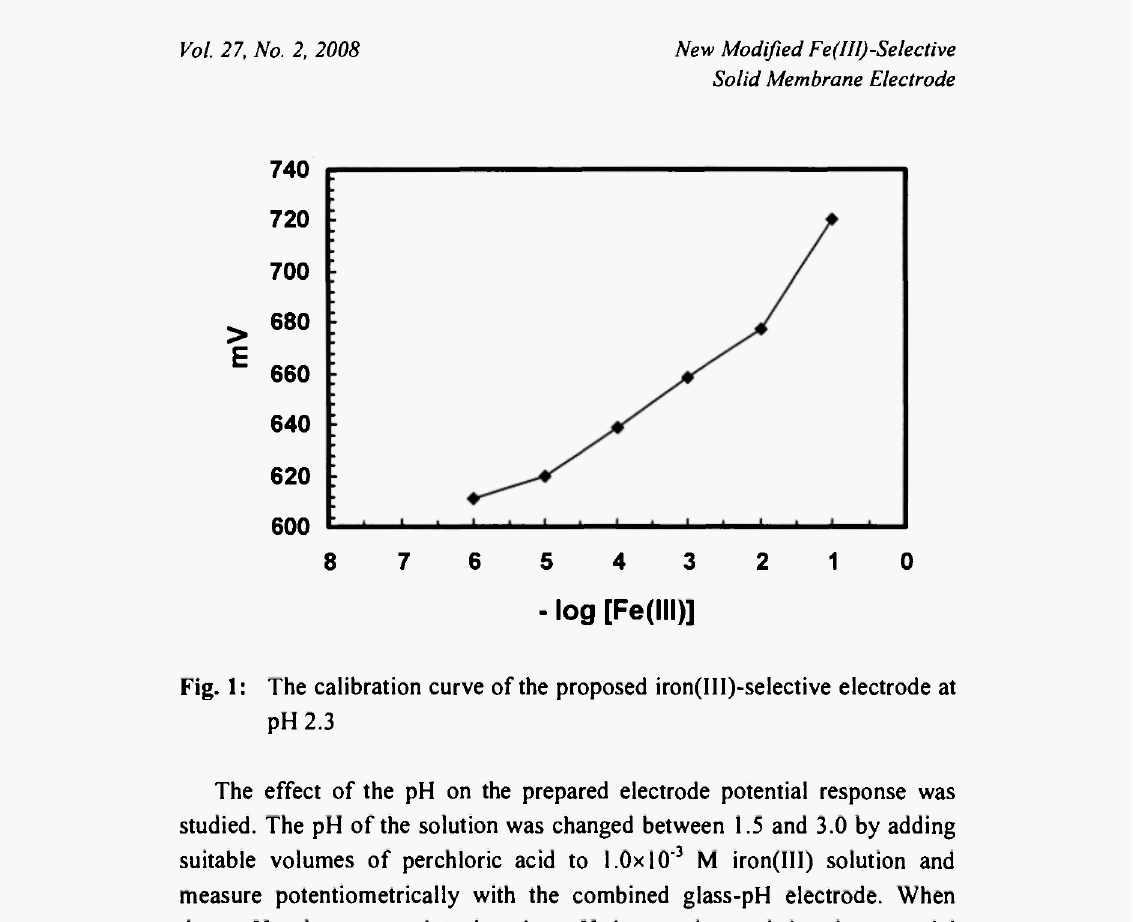
Fig. 1: The calibration curve of the proposed iron(III)-selective electrode at pH